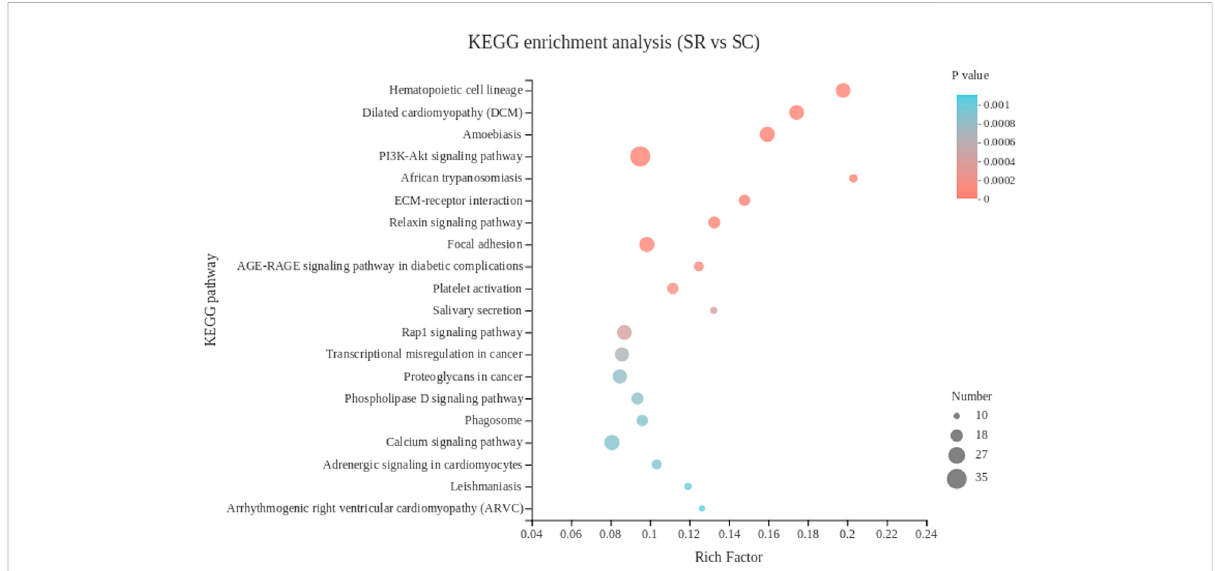
FIGURE 4 Thetop 20Kyoto EncyclopediaofGenesandGenomespathwaysofDEGsinspleen.The colorofthedotrepresentsthe p value,and thesize of the dot represents the number of DEGs enriched in the reference pathway. SR, spleen of rooster; SC, spleen of capon.